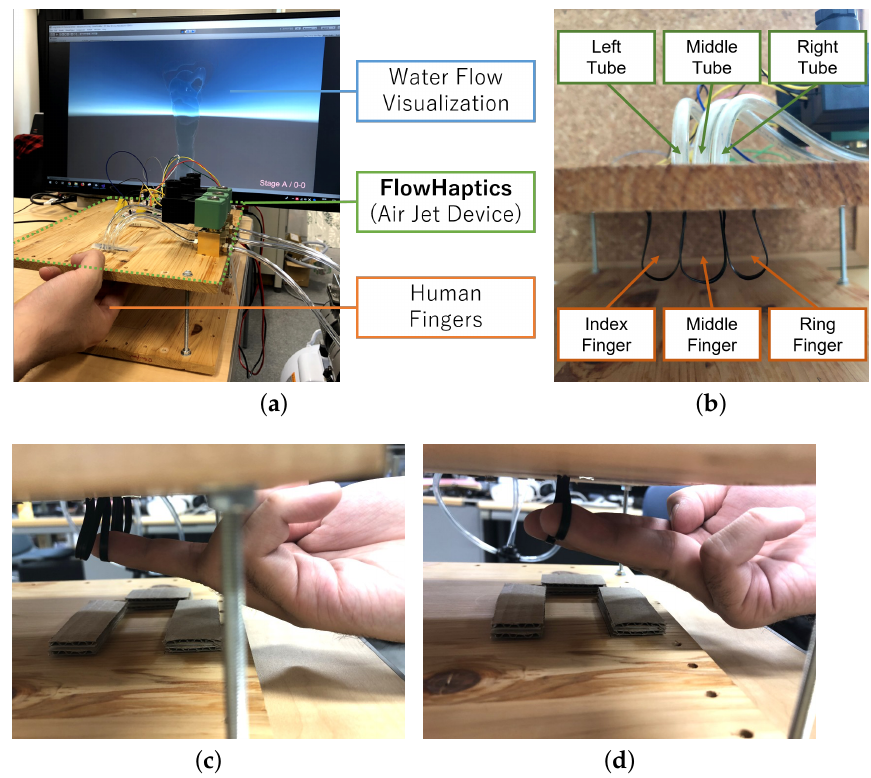
Figure 9. ( a ) Experimental setup; ( b ) front view of the device; ( c ) one finger; ( d ) three